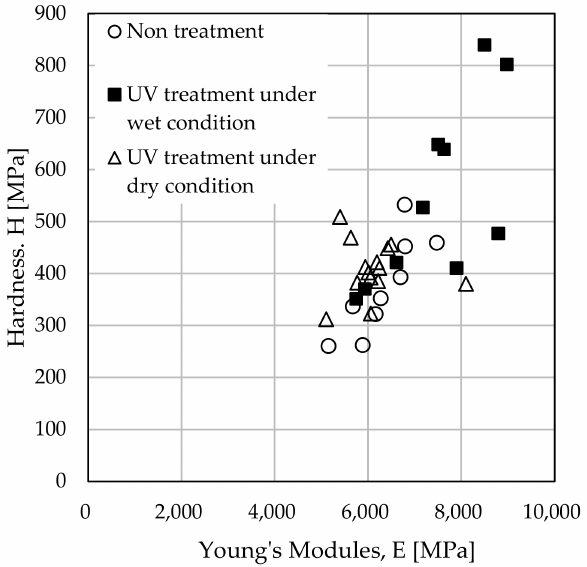
Figure 5. Young’s modulus and hardness of the surface of each test piece. (A504X90B) wet